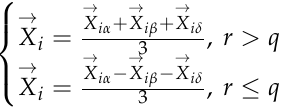
where s is calculated from the formula proposed by Mantegna. The differential evolution idea is utilized to update the position to strengthen the leadership influence of the alpha gray wolf over potential leaders in beta and delta gray wolves because of the differential evolution algorithm's strong local search capability in multimodal function search and grey wolf.